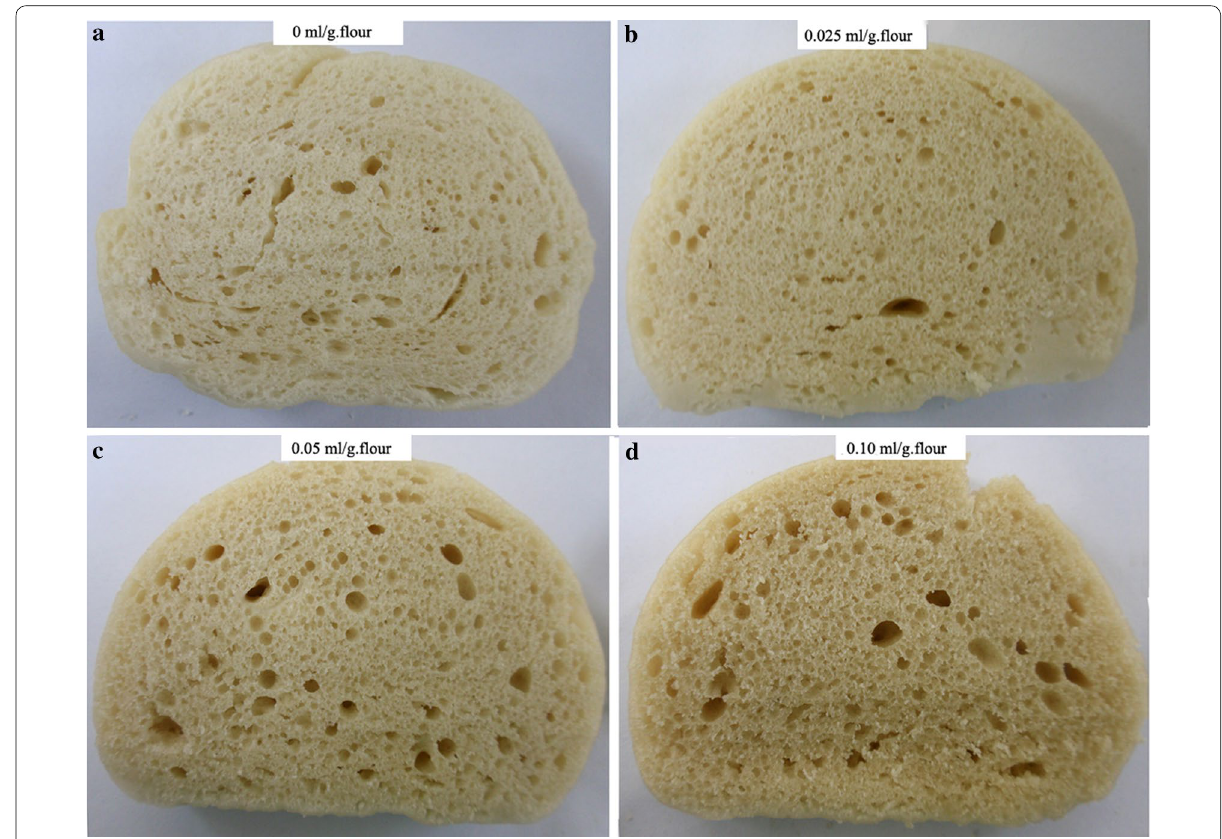
Fig. 2 Visual examination of the effect of FB G on pore size of the crumbs. a The reference; b 0.025 ml/g; c 0.05 ml/g; d 0.10 ml/g